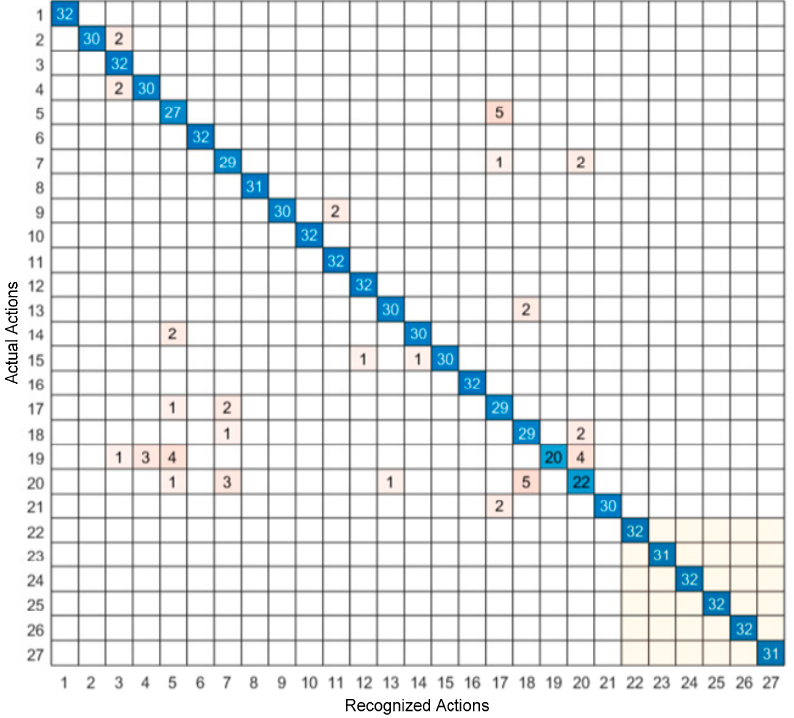
Figure 8. Confusion matrix of the feature-level fusion of video and inertial sensing modalities.